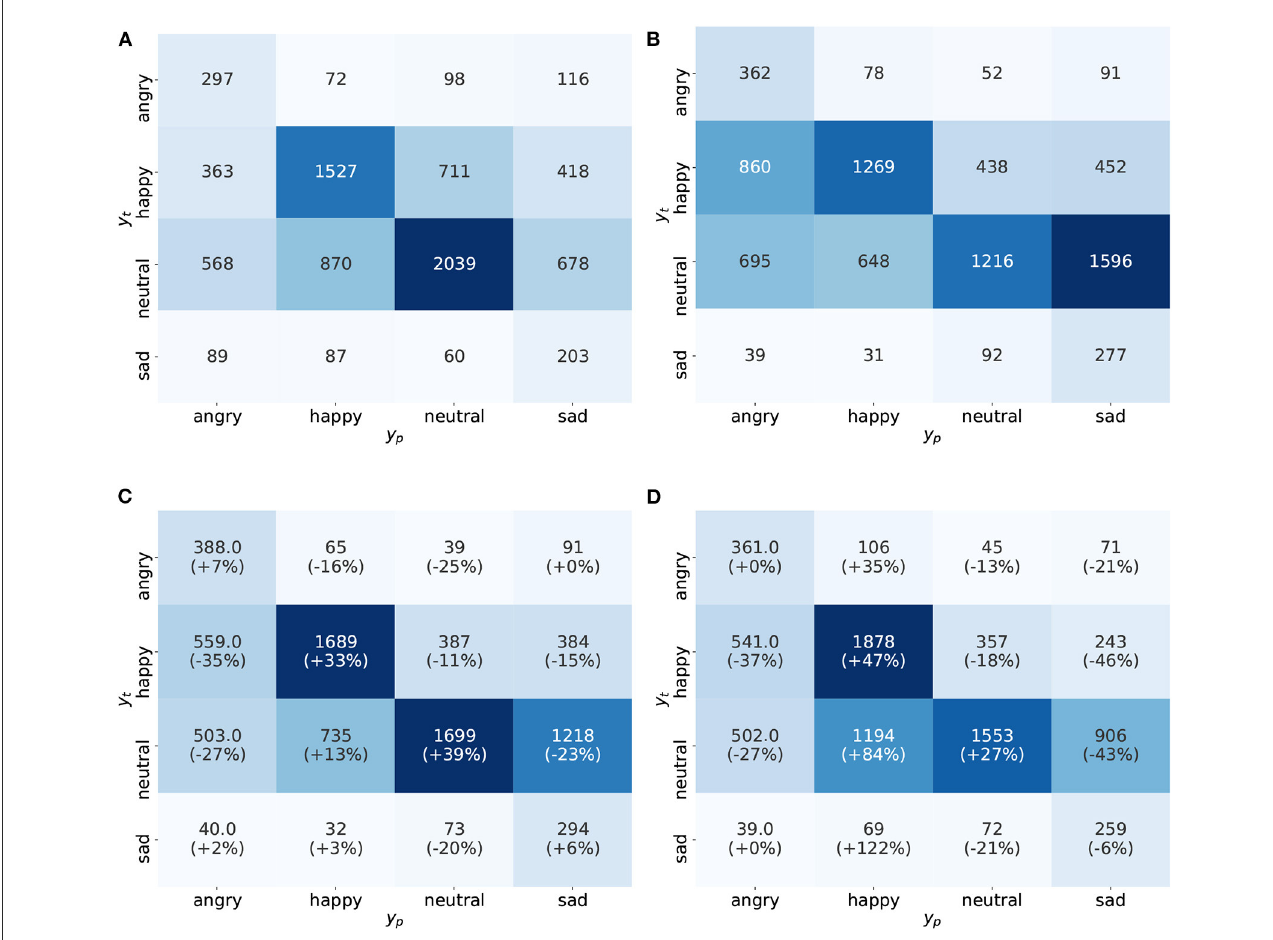
FIGURE3 Confusion matrices for the 4-class emotion classification task on MSP-Podcast. For each approach, we show results for the best performing seed. For the two fusion models, we additionally show % change with respect to CNN14 for easier comparison. (A) BERT, (B) CNN14, (C) SFCNN14, and (D) MFCNN14.